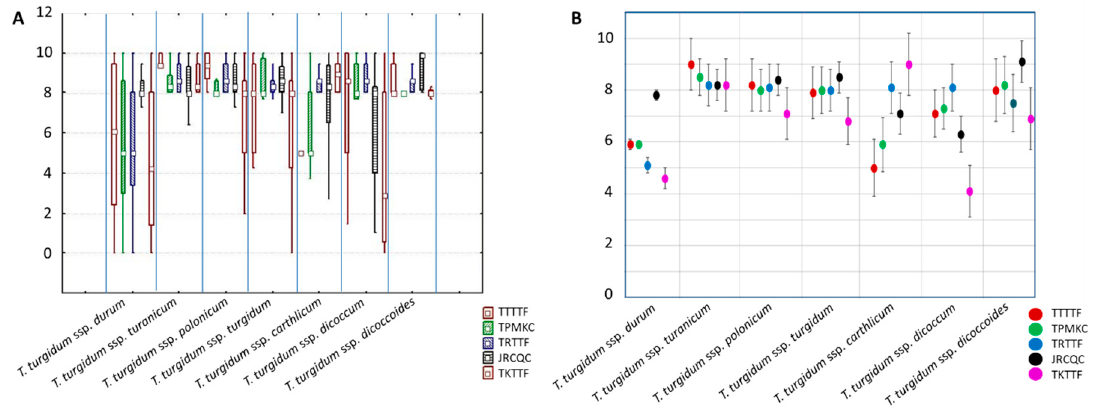
Figure 2. Phenotypic reaction to Puccinia graminis f. sp. tritici of the different subspecies. ( A ) Box plot showing the phenotypic variation for reactions of the tetraploid wheat subspecies groups to the five races of Puccinia graminis f. sp. tritici . ( B ) Detail of the mean values for reactions of the tetraploid wheat subspecies groups to the five races of Puccinia graminis f. sp. tritici . The vertical bars indicate the confidence interval at p < 0.05.